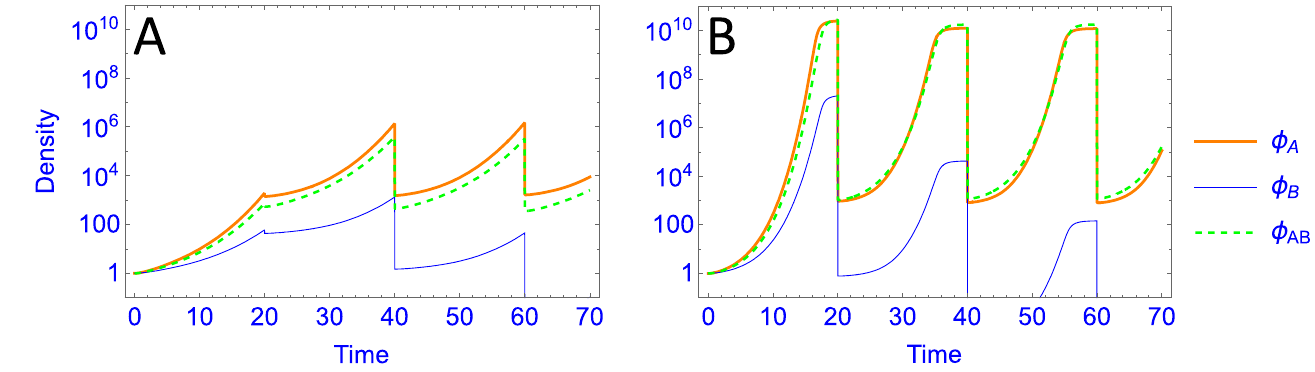
Figure 5. Temporal, short-term dynamics of phage in Parallel-presentation trials of Figure 4 (panel A above) and Figure 3 (panel B above); the generalist has burst sizes of 17 on both hosts, representing a point in the heat map of Figure 4 at which only the A-specialist is maintained but at which the A-specialist and generalist are maintained in Figure 3. Comparison of these dynamics reveals why the two growth conditions yield such differences in patterns of phage maintenance between the different conditions of Figures 3 and 4. With a low bacterial growth rate ( r = 0.1, A ) the phages never exhaust the bacteria before dilution; in essence, the phages are maintained in a constant state of exponential growth, and the fastest grower sets the threshold for dilution such that other phages are progressively diluted to extinction. Increasing the bacterial growth rate to r = 0.3 ( B ) has the unintuitive effect of allowing accelerated phage growth toward the end of a cycle; as cell densities reach high levels, phage growth accelerates, exhausting the cells. Even slowly growing phages can recover from low transfer densi ties and attain high densities by cycle’s end. This exhaustion of hosts allows slowly growing phages on one host to be maintained along with fast-growing phages on the other host. Note that there are no units of density or time because they are relative to each other, to the other variables, and to the parameters. See Methods for an explanation.